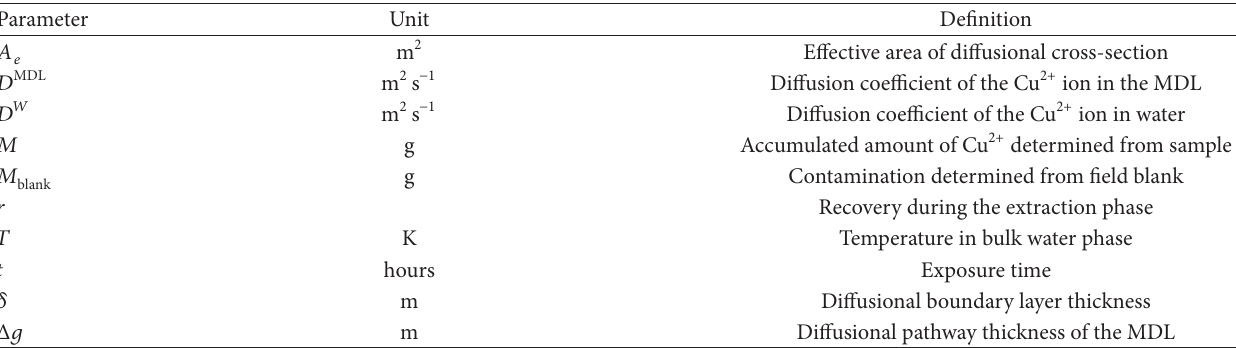
Table 2: Parameters for which uncertainty is determined and respective